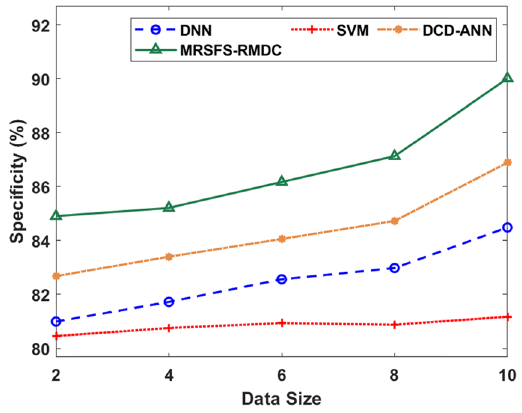
Figure 4: Speci fi city analysis of MRSFS - RMDC model with distinct data size.